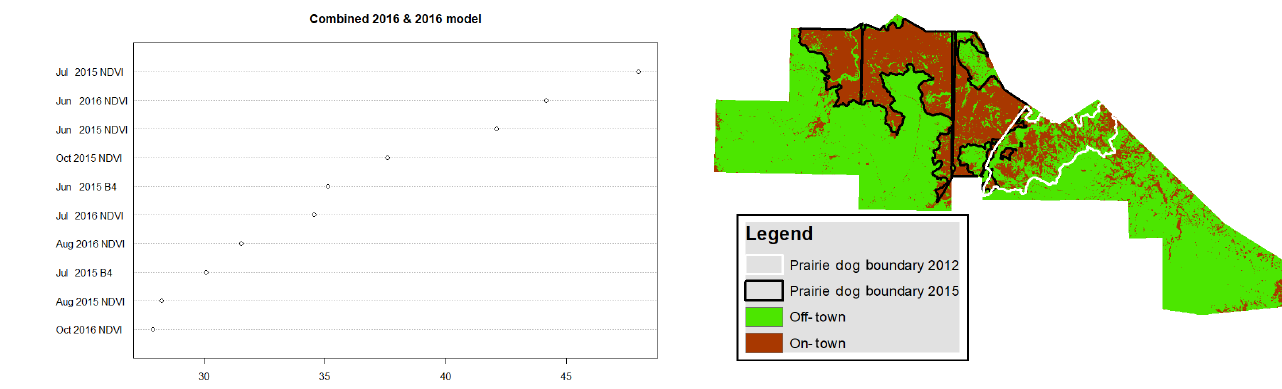
Figure 6. Random forest classification map created from predic- tions from the combined 2015 and 2016 models. Off-town areas were created by combining the predicted off-town plant communi- ties (Off-Cool, Off-Warm, and Off-Snow) and on-town plant com- munities (On-Grass and On-Forb). The prairie dog boundary was mapped using a handheld GPS unit; the outlined 2012 prairie dog boundary was former prairie dog colony poisoned in